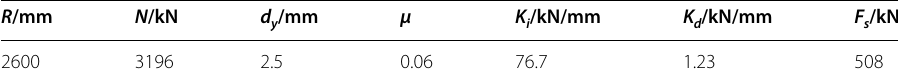
Table 1 Nominal properties of the FPB R